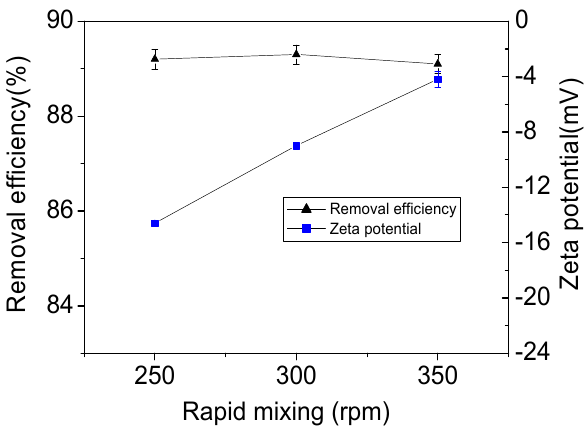
Figure 3. Effects of rapid mixing on removal efficiency and zeta potential.